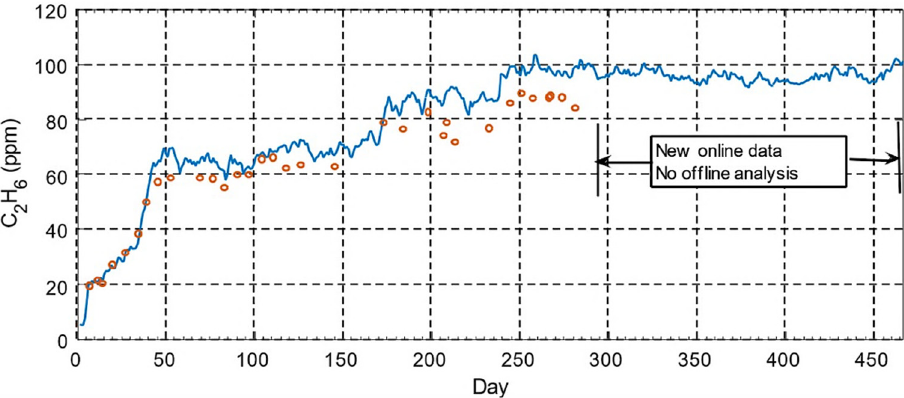
Figure 54. Evolution of ethane concentration over time, online (blue) and offline (orange) data.